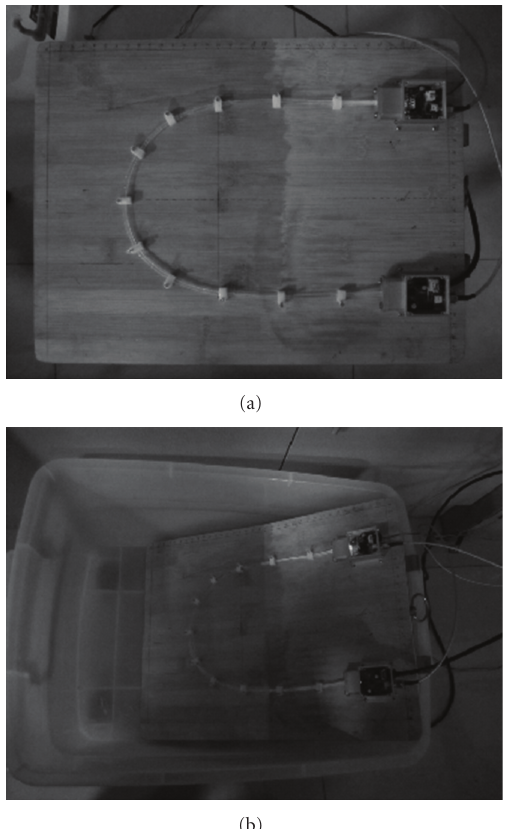
Figure 6: (a) and (b) are the experimental setup of attenuation coe ffi cient measurement for bended SEOF in air and